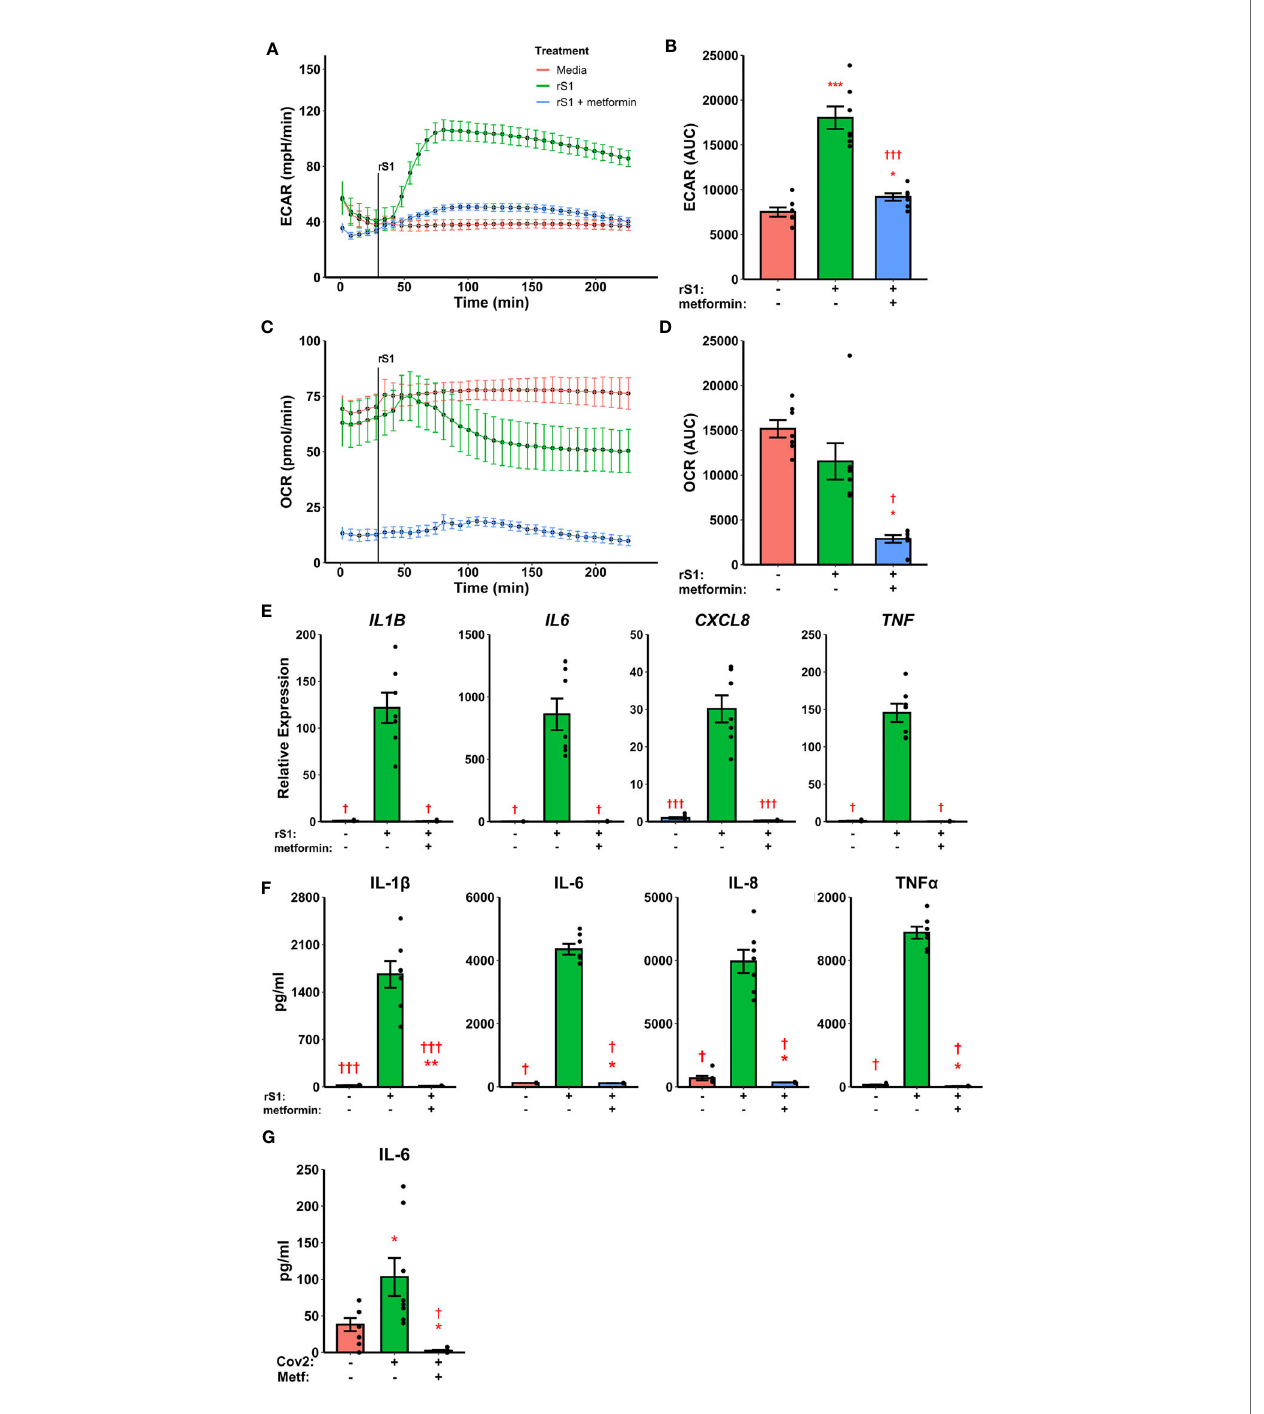
FIGURE 5 | Metformin suppresses immunometabolic activation in monocytes treated with recombinant spike protein (rS1). (A) Metformin pre-treatment blocks the increase in extracellular acidi fi cation rate (ECAR) mediated by rS1. (B) Quanti fi cation of ECAR by area under the curve (AUC). (C) Metformin suppresses oxygen consumption rate (OCR). (D) Quanti fi cation of OCR by AUC. (E) Metformin suppresses cytokine responses, as demonstrated by gene expression of IL1B , IL6 , CXCL8 , and TNF , during rS1 stimulation in monocytes. (F) Metformin suppresses protein production of pro-in fl ammatory cytokines IL-1 b , IL-6, IL-8, and TNF a during S1 stimulation in monocytes. (G) Metformin inhibits IL-6 production in monocytes infected with SARS-CoV-2 strain WA1/2020 (Cov2) at 0.5 MOI. *, **, ***: p < 0.05, p < 0.01, p < 0.001 vs . unstimulated cells. † , ††† : p < 0.05, p < 0.001 vs . rS1-treated or Cov2-infected cells. N = 7-8 biological replicates. Bars and error bars are mean ±